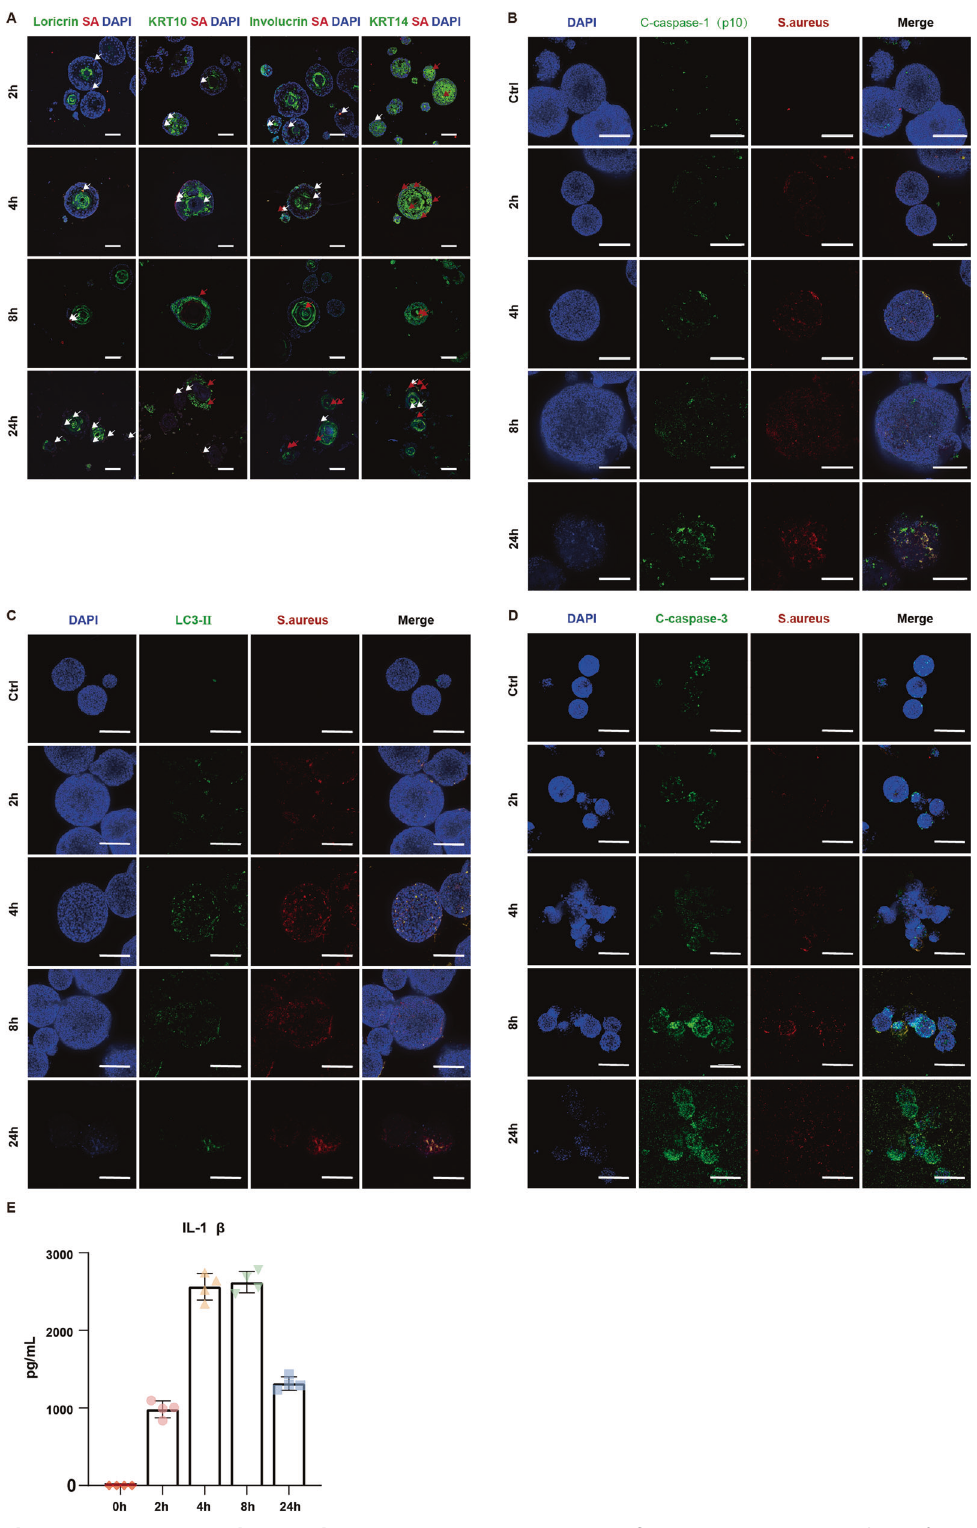
Fig. 5 USA300 induces pyroptosis, autophagy and apoptosis in mPEOs. A Immuno fl uorescence staining analysis of Staphylococcus aureus biomarkers and Loricrin, KRT10, Involucrin, and KRT14 in mPEOs at 0, 2, 4, 8, and 24 h after USA300 infection. White arrows represent the location of USA300, and red arrows represent the colocalization of USA300 with Loricrin, KRT10, Involucrin or KRT14. (Scale bars, 200 μ m). B Immuno fl uorescence staining analysis of the Staphylococcus aureus biomarker and Cleaved-caspase-1 (p10) in mPEOs 0, 2, 4, 8, and 24 h after USA300 infection (scale bars, 200 μ m). C Immuno fl uorescence staining analysis of Staphylococcus aureus biomarkers and LC3-II in mPEOs after USA300 infection at 0, 2, 4, 8, and 24 h (scale bars, 200 μ m). D Immuno fl uorescence staining analysis of Staphylococcus aureus biomarkers and Cleaved-caspase-3 in mPEOs after USA300 infection at 0, 2, 4, 8, and 24 h (scale bars, 200 μ m). E IL-1 β production was determined using ELISA at 0, 2, 4, 8, and 24 h after mPEOs were infected with